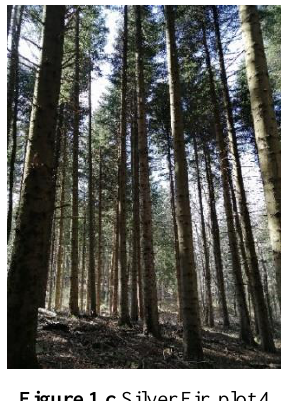
Figure 1.c Silver Fir, plot 4